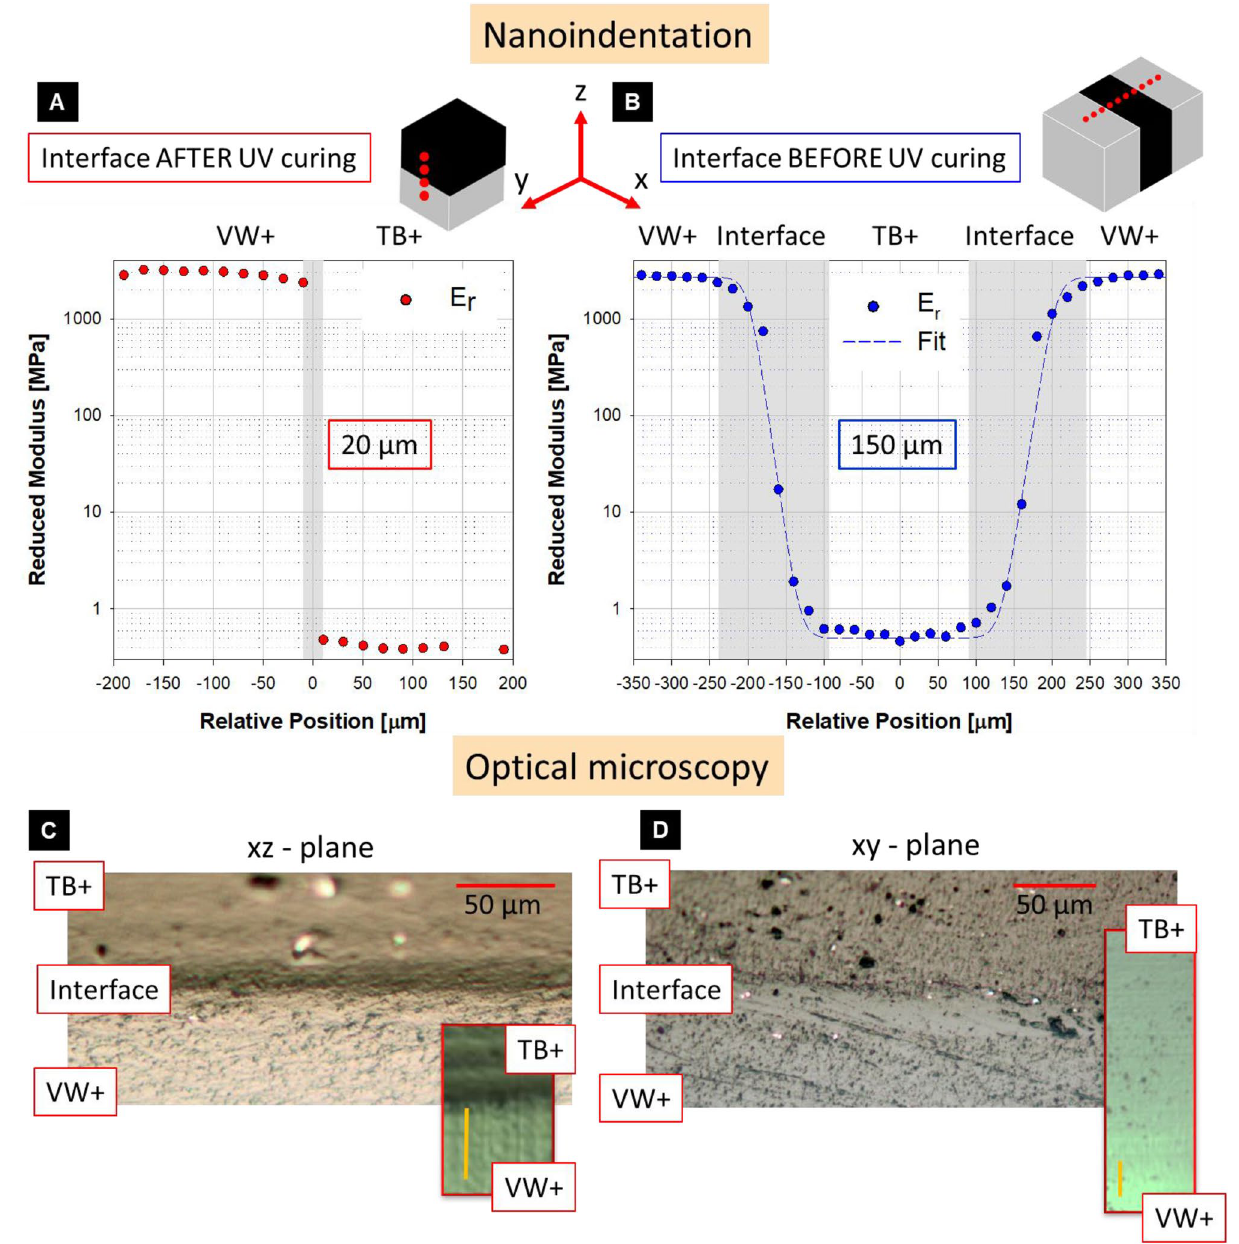
Figure 3. Nanoindentation and optical microscopy results. Spatial variation in reduced elastic modulus (Supplemetary Information, Eqs. S1 and S3) across bimaterial interfaces formed ( A ) after and ( B ) before UV curing. The grey areas in the figures highlight the interface widths in the two scenarios (20 and 150 μm, respectively). At the top, sketch of cuboid samples (TB + and VW + in black and light grey, respectively) showing the printing orientation and indents position. The results are relative to one sample per configuration and to a single indentation line per sample. The other regions which were probed had a quantitatively similar behavior but more data points had to be excluded due to unsatisfactory surface preparation or irregular indentation curves. Inspection of the polished surface of bimaterial samples with optical microscopy confirmed ( C ) sharp and ( D ) broad interfaces for the two printing scenarios. Insets show close-up on the interface region on the cryomicrotome-smoothed samples used for nanoindentation (scale bar 25 transition between the darker TB + and the lighter WV + was much more gradual than in the previous scenario and occurred over a region spanning at least 120–140 µm. The optical micrographs of the bimaterial samples differed substantially from those of the commercial blends. The latter were characterized by fiber-like inclusions of the rubbery component into the glassy VW + matrix 13 (Supplemetary Information, Figure S2). Conversely, even within the broad interfacial region of the bimaterial samples, such inclusions were not detected, suggesting